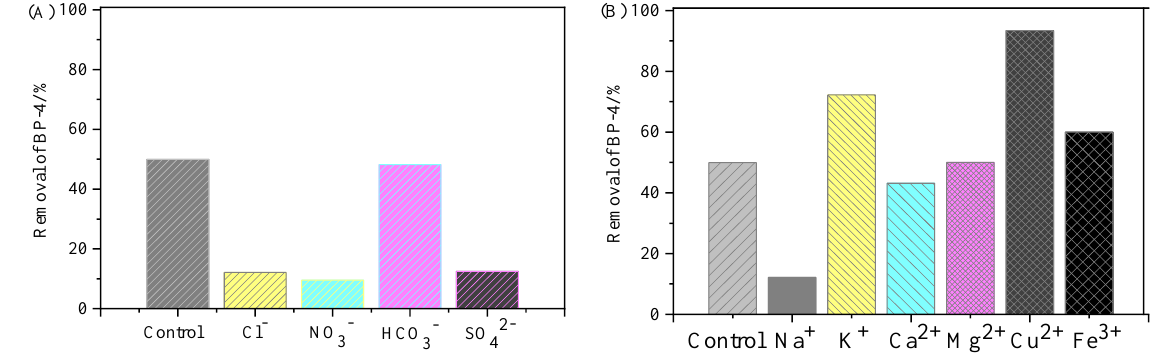
Figure 3. Effect of anions ( A ) and cations ( B ) on the removal of BP-4 after 10 min. [Anions] = [Cations] = 5 mM.